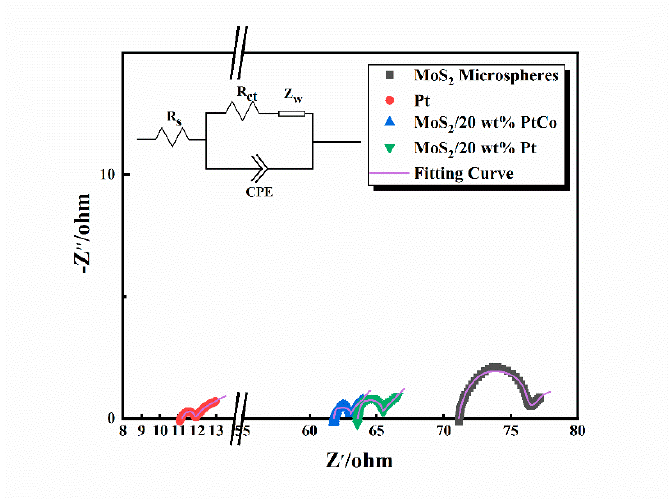
Figure 7. Electrochemical impedance spectroscopy (EIS) of dummy cells fabricated with two identical MoS 2 /20 wt% PtCo, MoS 2 /20 wt% Pt, MoS 2 microspheres, conventional Pt counter electrodes (CEs) and corresponding fitting curves. The equivalent circuit model is inserted in it.